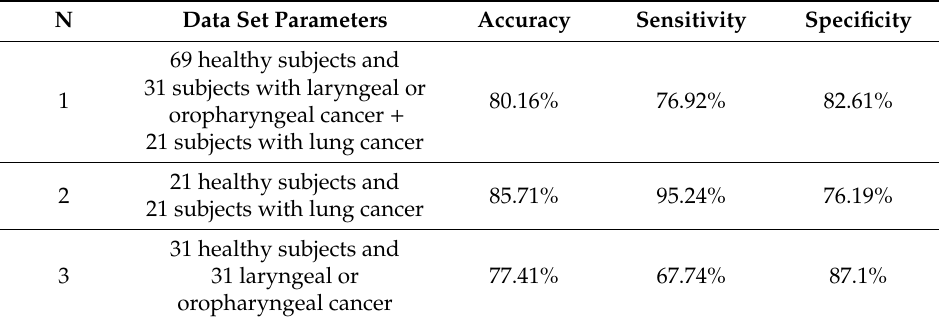
Table 3. Achieved parameters of the gas analysis system.